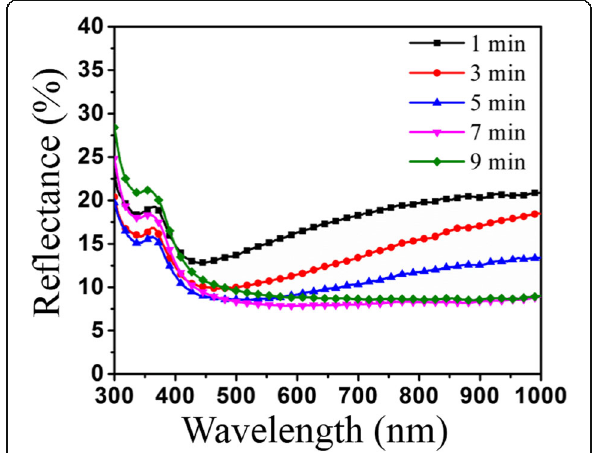
Fig. 5 Reflectance spectra of inverted pyramid structures with texturing for different time. Reflectance spectra of sc-Si with inverted pyramid structures for alkaline texturing time at 1, 3, 5, 7, and 9 min, respectively